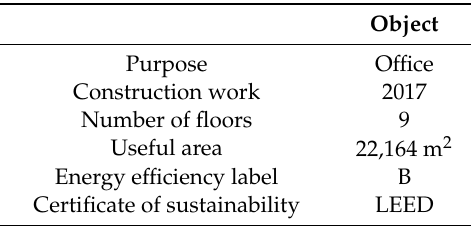
Table 2. General data of the